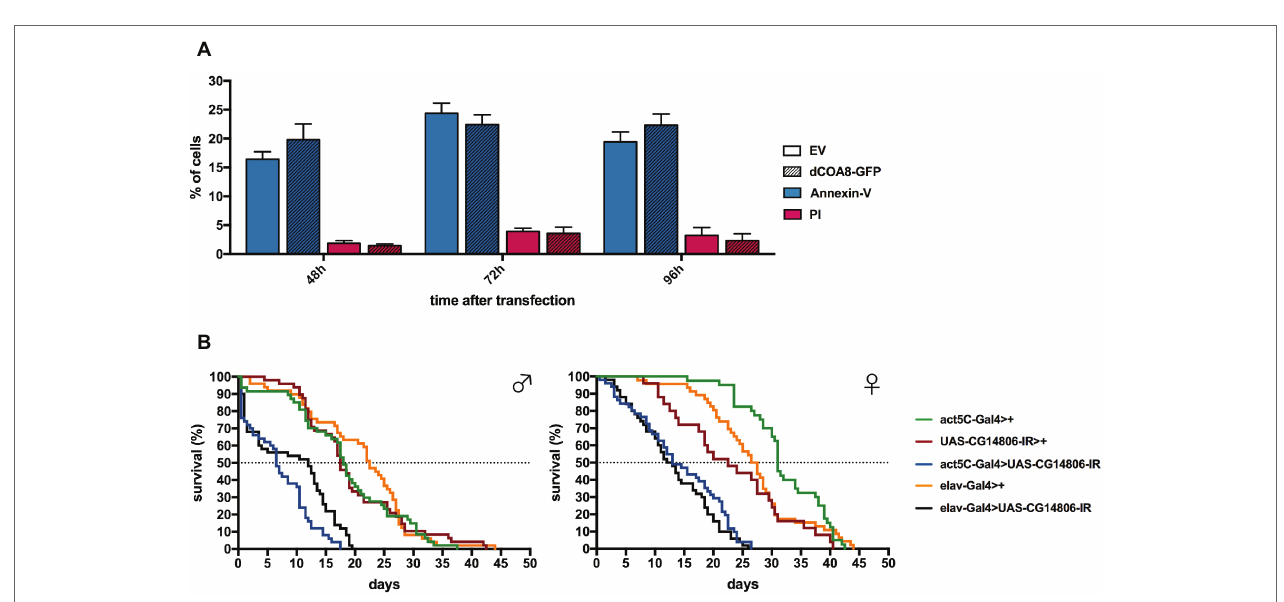
FIGURE 2 | Functional characterization of dCOA8 . (A) Cell death analysis. dCOA8-GFP over-expressing and control S2R+ cells (transfected with an empty vector expressing a cytosolic GFP) were double-stained with Annexin V and propidium iodide (PI). Percentage of early apoptotic (blue bars) and necrotic (red bars) cells was measured 48, 72, and 96 h post-transfection. Data plotted are mean ± S.D. ( n = 3 biological replicates, two-way ANOVA with Sidak’s multiple comparisons test not significant). (B) Representative lifespan curves (Kaplan-Meier) of ubiquitous (act5C-Gal4 > UAS-CG14806-IR) and pan-neuronal (elav-Gal4 > UAS-CG14806-IR) dCOA8 KD flies with respect to parental controls (UAS-CG14806-IR>+, act5C-Gal4>+, and elav-Gal4>+) under oxidative stress at 23°C. Flies were treated with 20 mM Paraquat in standard food. Statistical analysis was performed with log-rank (Mantel-Cox). All the comparisons between the two KD lines with respect to parental controls are statistically significant (**** p ≤ 0.0001).